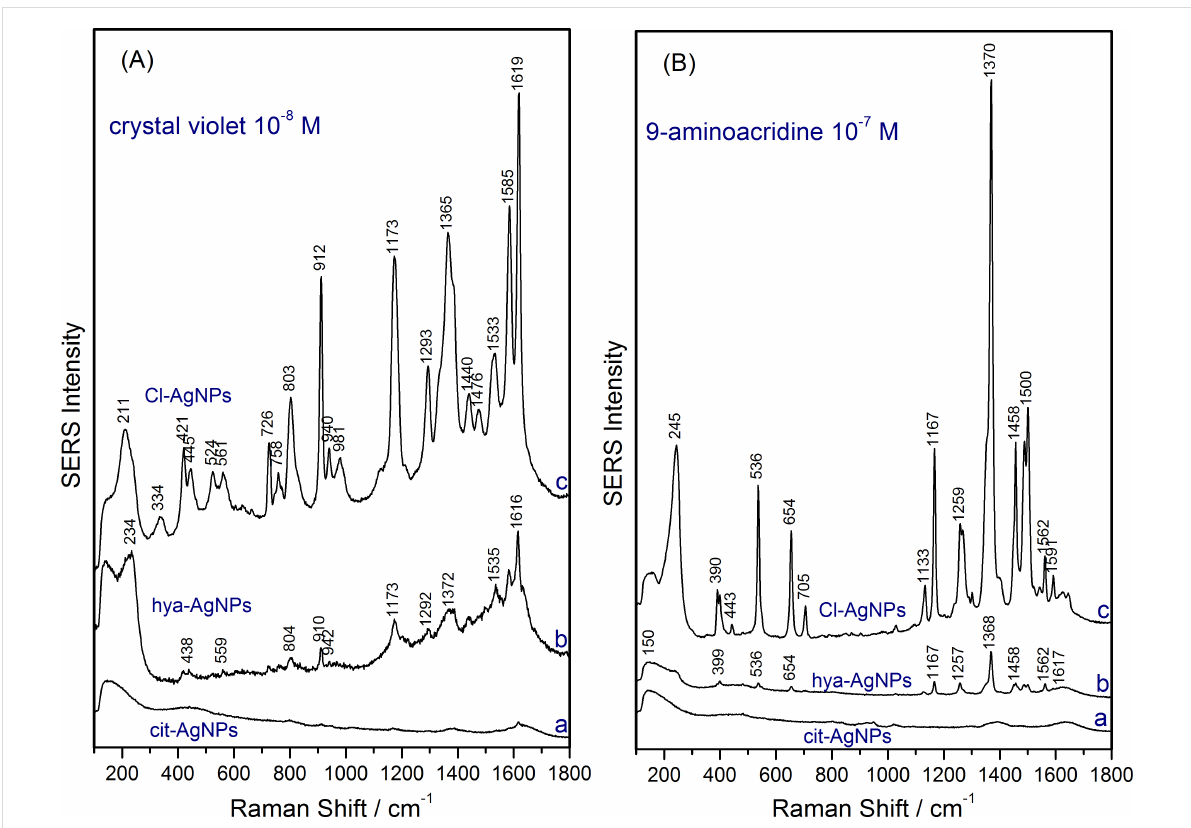
Figure 4: (A) SERS spectra of crystal violet 10 − 8 M and (B) 9-aminoacridine 10 − 7 M obtained using three different silver colloidal solutions as sub- strate: cit-AgNPs (a), hya-AgNPs (b), and Cl-AgNPs (c), as indicated in the